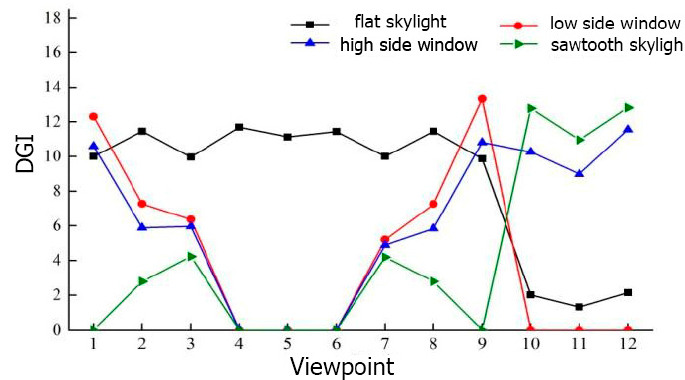
Figure 13. DGI values of the exhibition hall under various conditions.